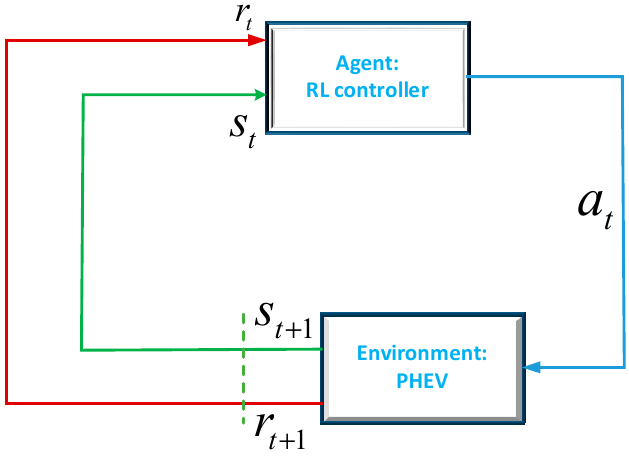
Figure 5. The agent-environment interaction.